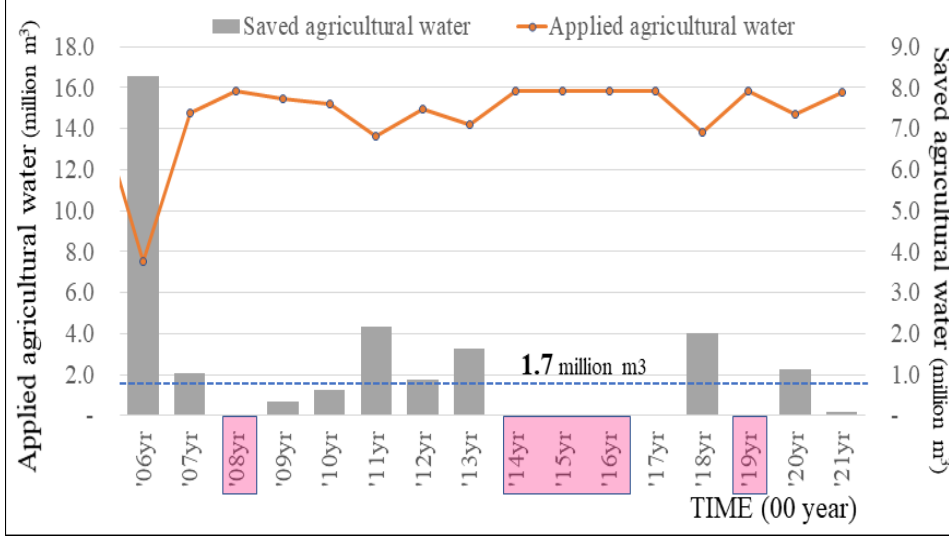
Figure 8. Annual supplied and saved amount of agricultural water of the Hoengseong Dam; red box indicated the year that can’t save agricultural water due to drought .